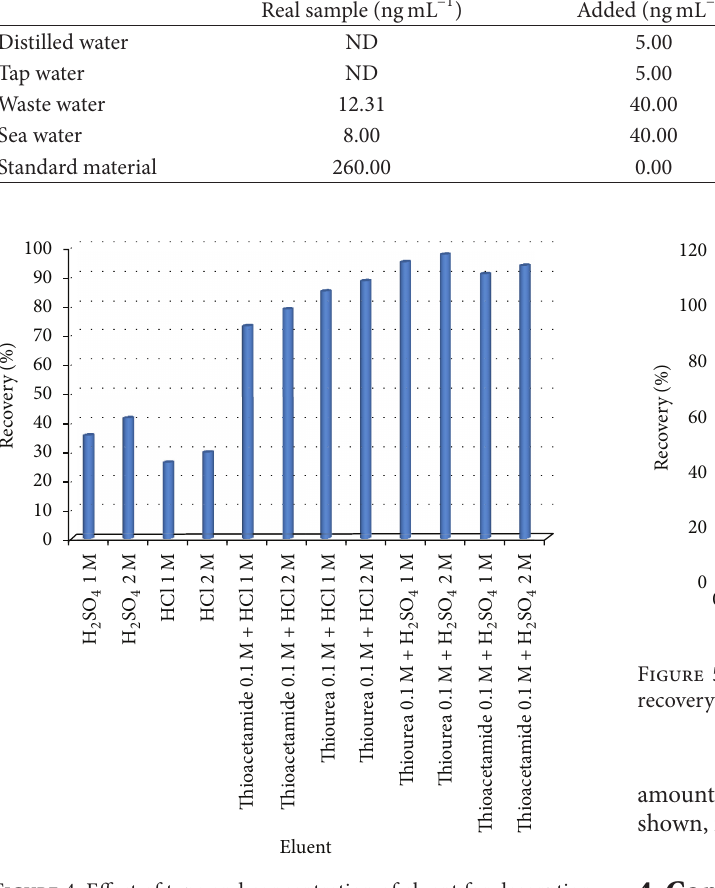
F 4: Effect of type and concentration of eluent for desorption of Au(III) by 9-acridinylamine alumina.